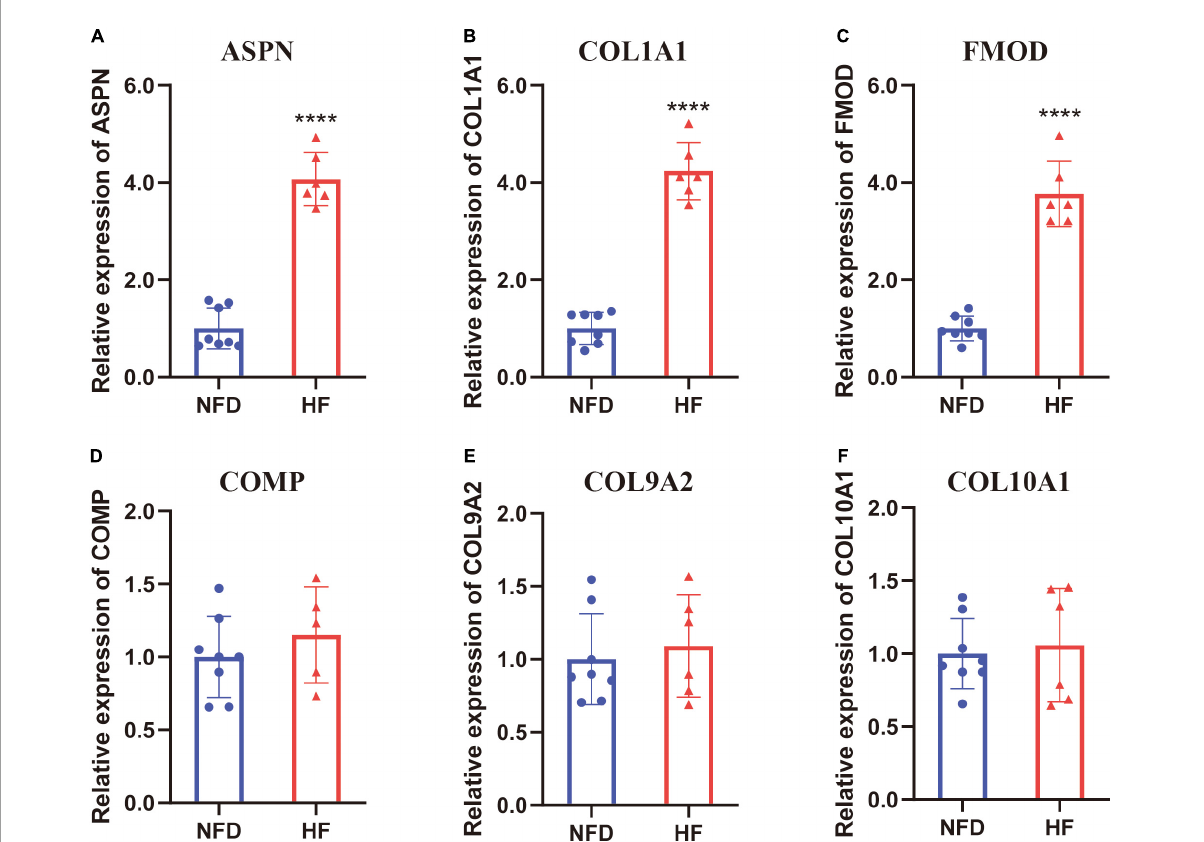
FIGURE9 Validation of the six hub genes by qRT-PCR using human heart tissues from patients with HF and NFDs. The expression level of ASPN (A) , COL1A1 (B) , FMOD (C) , COMP (D) , COL9A2 (E) , and COL10A1 (F) in heart tissues from HF patients and NFDs, as determined by qRT-PCR. Data are presented with mean ± SD. **** p < 0.0001 vs. the NFD group. QRT-PCR, quantitative real-time reverse transcription PCR; HF, heart failure; NFD, non-failing donor; SD, standard